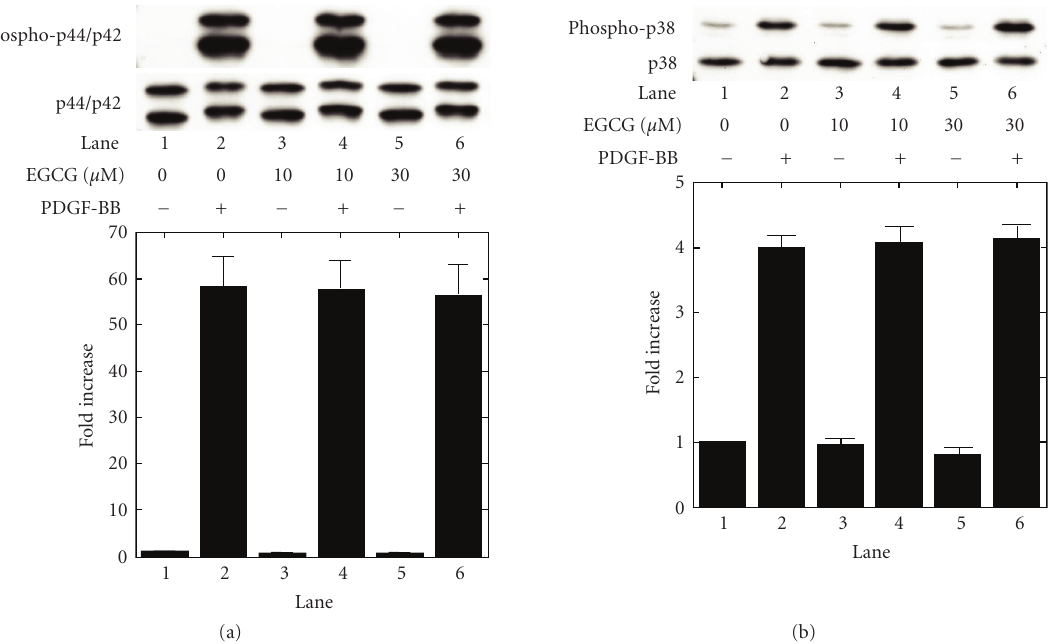
Figure 3: E ff ect of EGCG on the phosphorylation of p44/p42 MAP kinase and p38 MAP kinase induced by PDGF-BB in MC3T3-E1 cells. The cultured cells were pretreated with the indicated doses of EGCG or vehicle for 60 minutes, and then stimulated by 50ng/mL PDGF-BB or vehicle for 3 minutes. The extracts of cells were subjected to SDS-PAGE with subsequent Western blotting analysis with antibodies against (a) phospho-specific p44/p42 MAP kinase or p44/p42 MAP kinase, and (b) phospho-specific p38 MAP kinase or p38 MAP kinase. The histogram shows quantitative representations of the levels of PDGF-BB-induced phosphorylation obtained from laser densitometric analysis of three independent experiments. Each value represents the mean ± SEM of triplicate determinations. Similar results were obtained with two additional and di ff erent cell